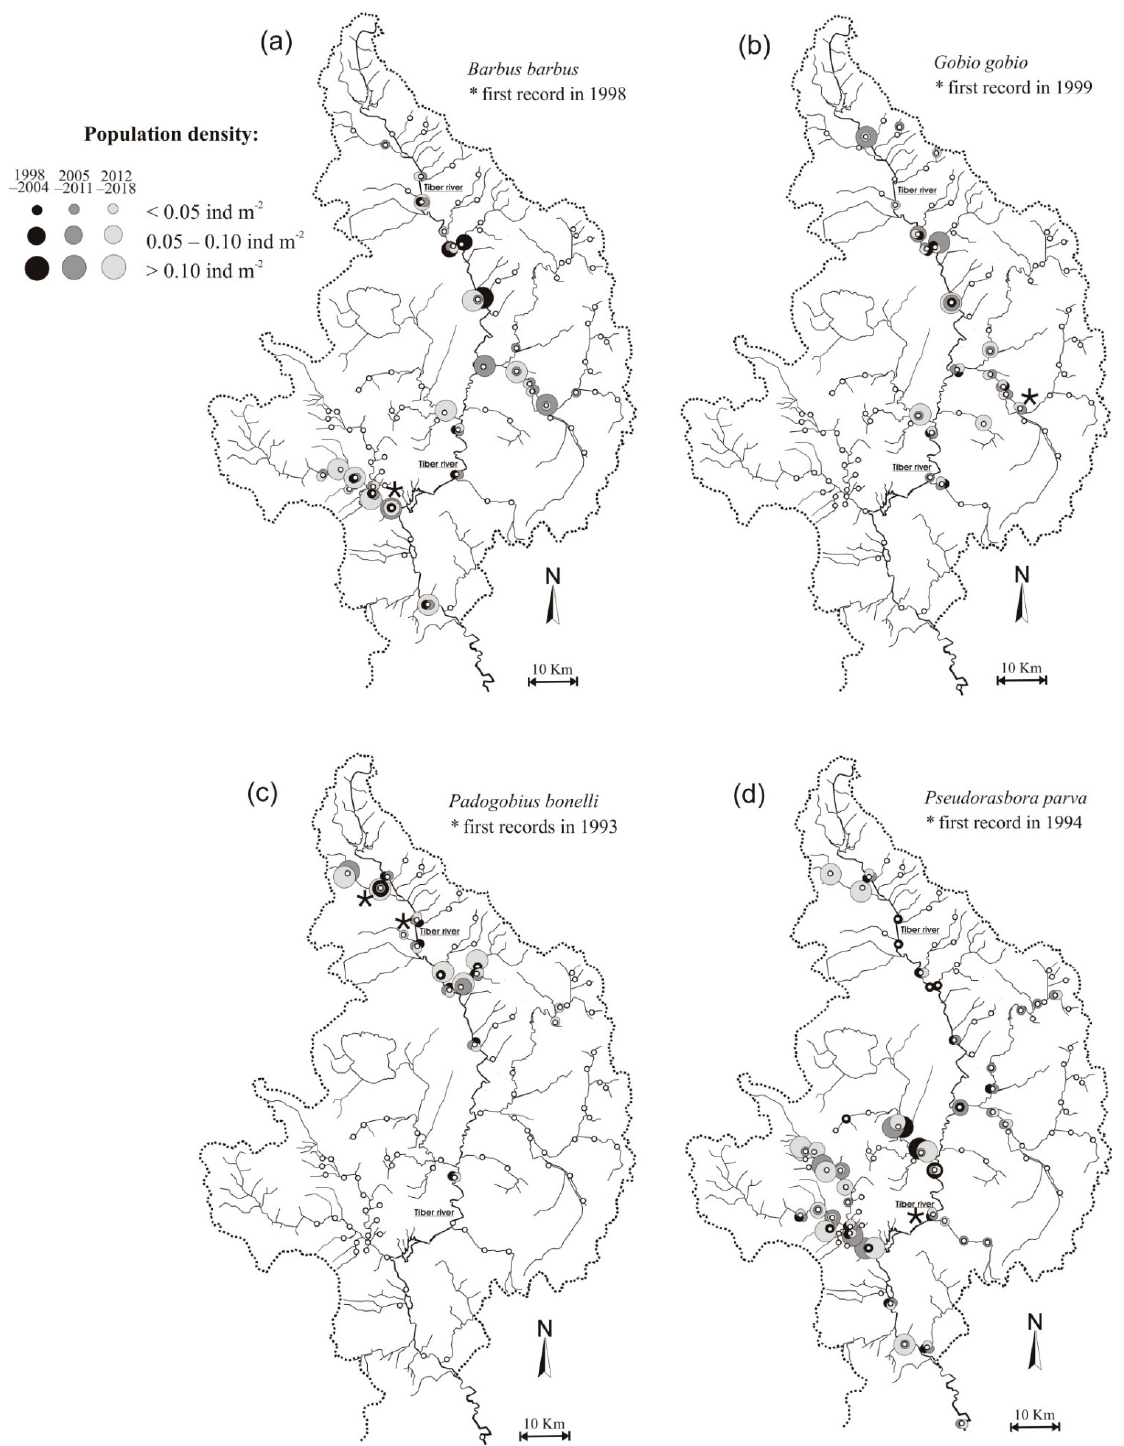
Figure 2. Comparison of the distribution and population abundances between the periods 1998–2004 (black circles), 2005–2011 (dark grey circles), and 2012–2018 (light grey circles) for: ( a ) Barbus barbus ; ( b ) Gobio gobio ; ( c ) Padogobius bonelli ; ( d ) Pseudorasbora parva